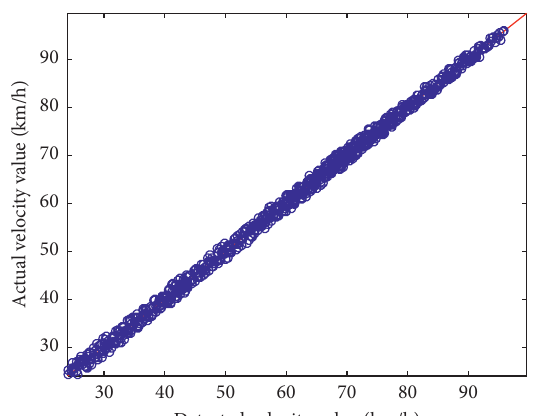
Figure 9: Actual velocity value and the detected velocity value calibrating based on numerical optimization of multireader velocity based on the particle swarm-optimized RBF neural network.